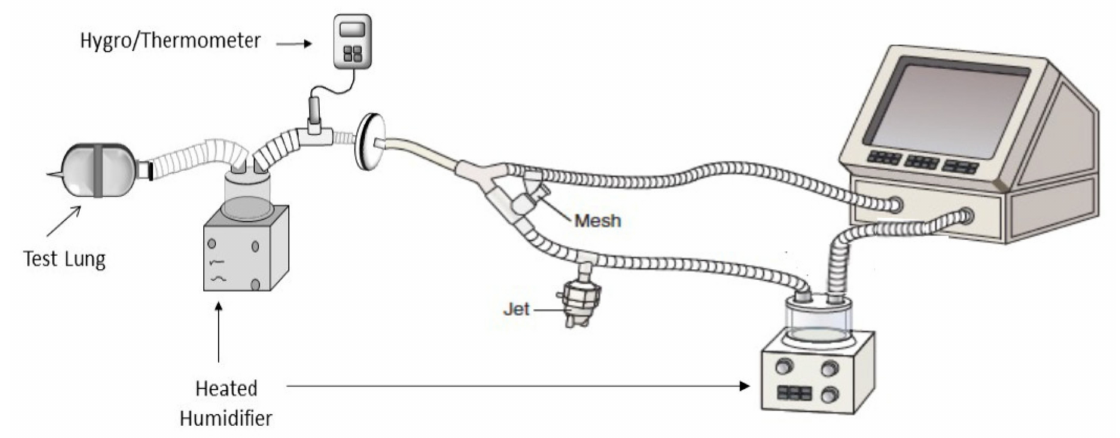
Figure 4. Lung model used to simulate pediatric mechanical ventilation. Adapted from [21], ERJ Open Research,